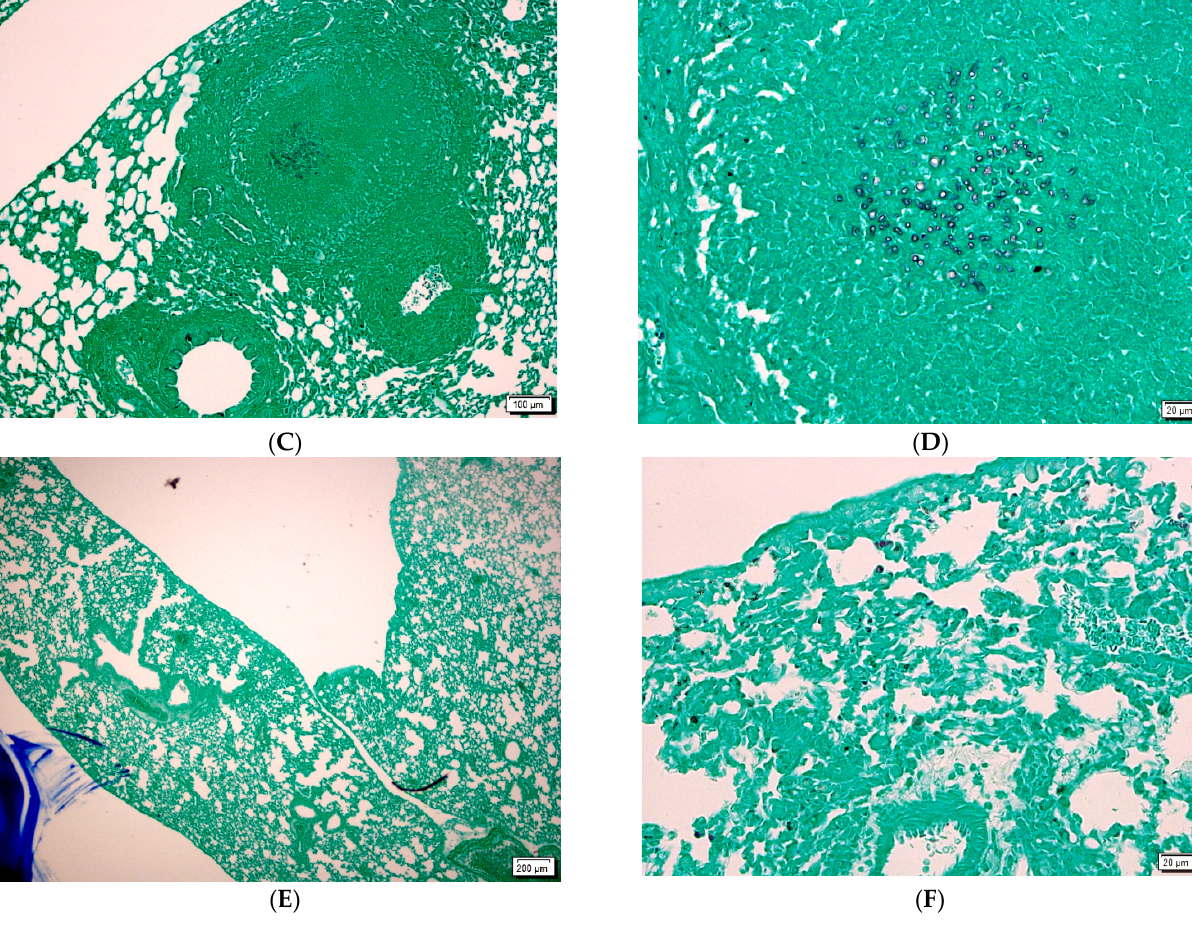
Figure 3. ( A – F ). ( A , B ): aspergilloma in the lung of infected animal with GMS stain. ( C , D ): aspergilloma in the lung of infected and AMB treated animal with GMS stain. ( E , F ) lung of infected and DIMICAN treated animals with GMS strain. Scale bars ( A , C , E ) are 200 μ m. Scale bars ( B , D , F ) are 20 μ m.